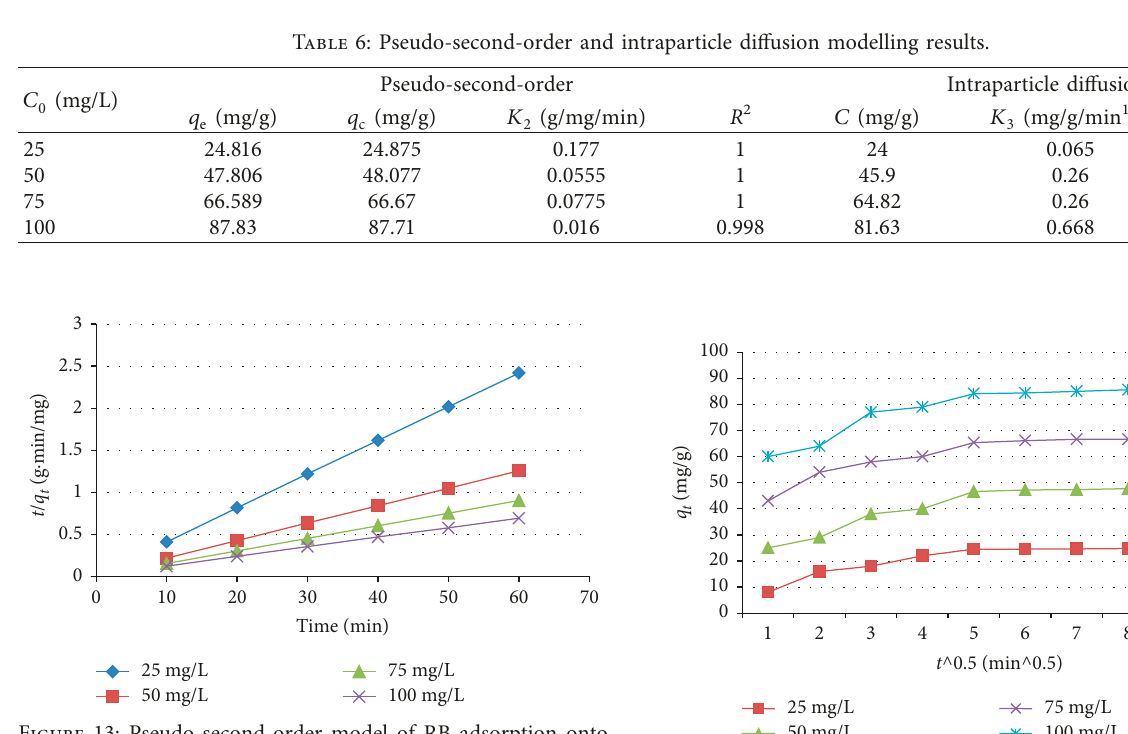
Figure 13: Pseudo-second-order model of RB adsorption onto 60min, pH of the solution Fe 2 O 3 -13X-Ms. Time (cid:30) factant amount 100 mg/L. (cid:30)